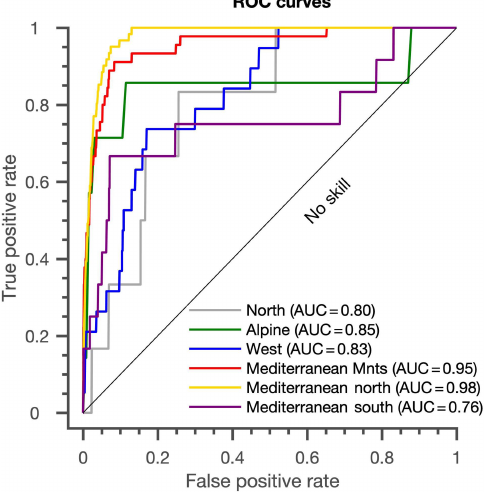
Figure 3. Area under the curve (AUC) illustrating the performance of each model. Mnts stands for mountains.